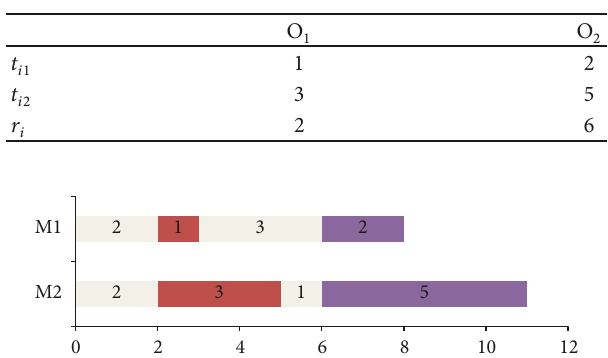
Figure 1: The Gantt diagram of the completion times of two